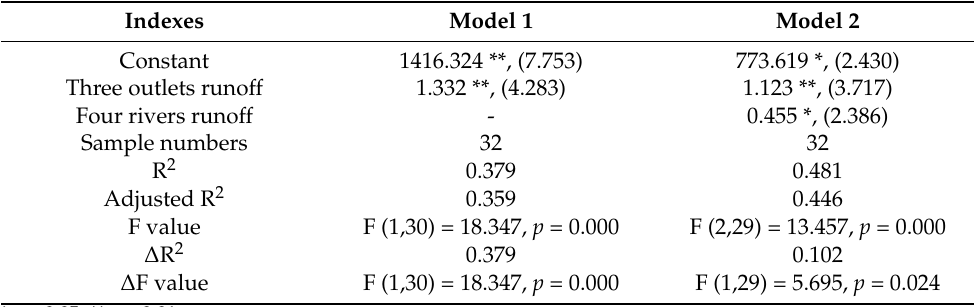
Table 8. Result of the hierarchical regression analysis for hydrological